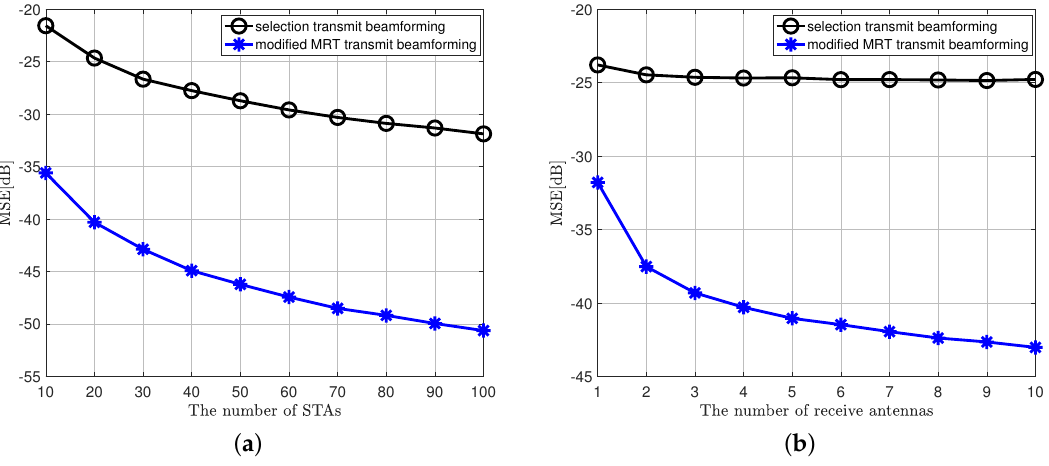
Figure 4. MSE performance of the proposed MIMO AirComp framework and other transmit beamforming technique, when SNR is 10 dB, objective function is arithmetic mean. ( a ) MSE performance when N T = 2, N R = 4. ( b ) MSE performance when N T = 2, K =